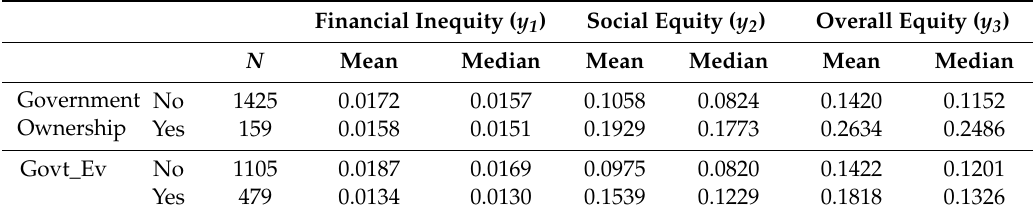
Table 4. Distribution of equity indicators by government ownership and evaluation.